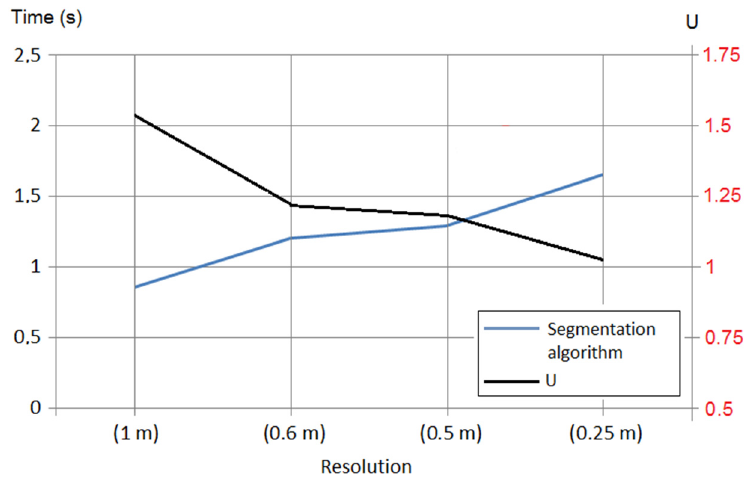
Figure 10. Computation time vs. image resolution and